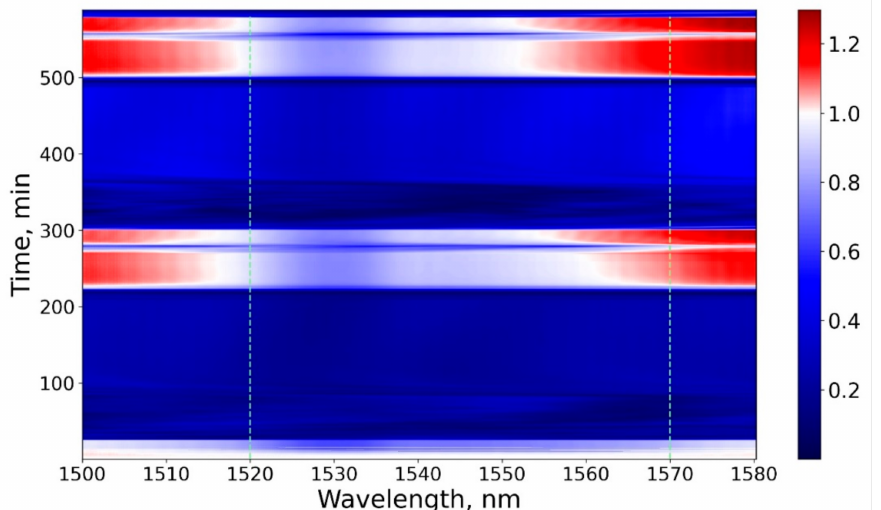
Figure 5. Temporal dynamics of the output spectrum normalized to the spectrum at the initial moment.